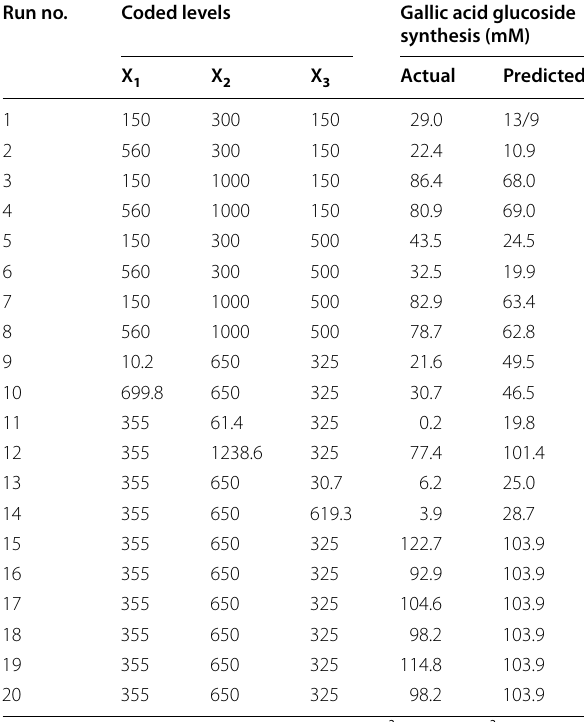
Y 158.9 = − 0.00089X 32 −